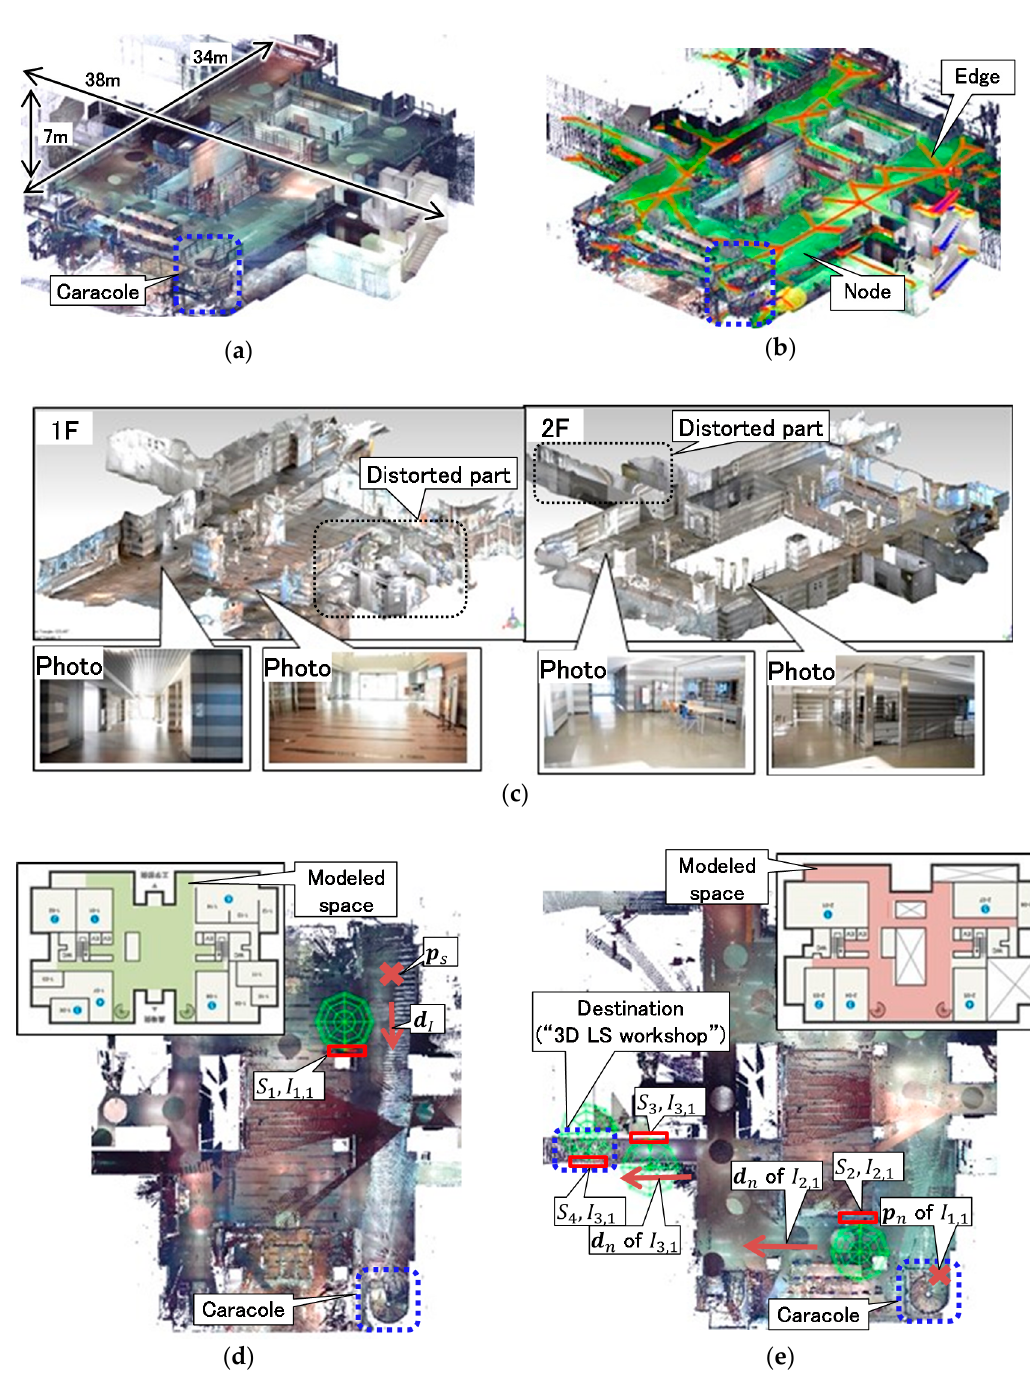
Figure 12. As-is environment model of two-story indoor environment: ( a ) Laser-scanned point clouds (#points: 5,980,647); ( b ) navigation graph G N ; ( c ) textured environmental geometry G I (#vertices: 625,484, #faces: 1,241,049); ( d ) wayfinding scenario on first floor [35]; ( e ) wayfinding scenario on second floor [35]. The results are available in the supplementary video file.